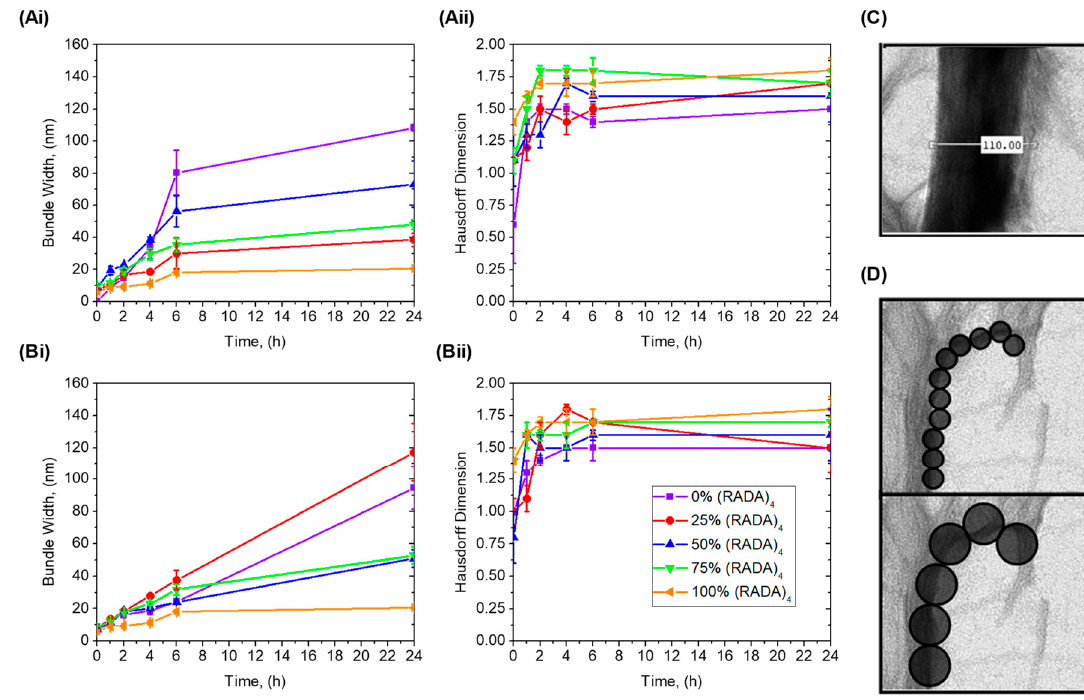
Figure 8. Bundle thickness and fractal dimension analysis for (RADA) 4 systems. ( A ) Bundle thickness and ( B ) Hausdorff box-count dimensions of (RADA) 4 -GG-GPQG+IASQ ( i ) and (RADA) 4 -GG- GPQG+PAGQ ( ii ) mixtures with (RADA) 4 . Example images of ( C ) thickness measurement and ( D ) fractal contour tracing. Thickness image outlines the number of pixels across one bundle, which is used to calculate bundle width from scale bar. Mixtures include 100%, 75%, 50%, 25%, and 0% volume (RADA) 4 -GG-GPQG+IASQ/(RADA) 4 -GG-GPQG+PAGQ in (RADA) 4 . By sample, 50 random thicknesses were chosen for three independent images, from three independent experiments (i.e., n = 3, with 150 random measurements). Data analyzed represents mean ± SD, where line is to guide the eye only.